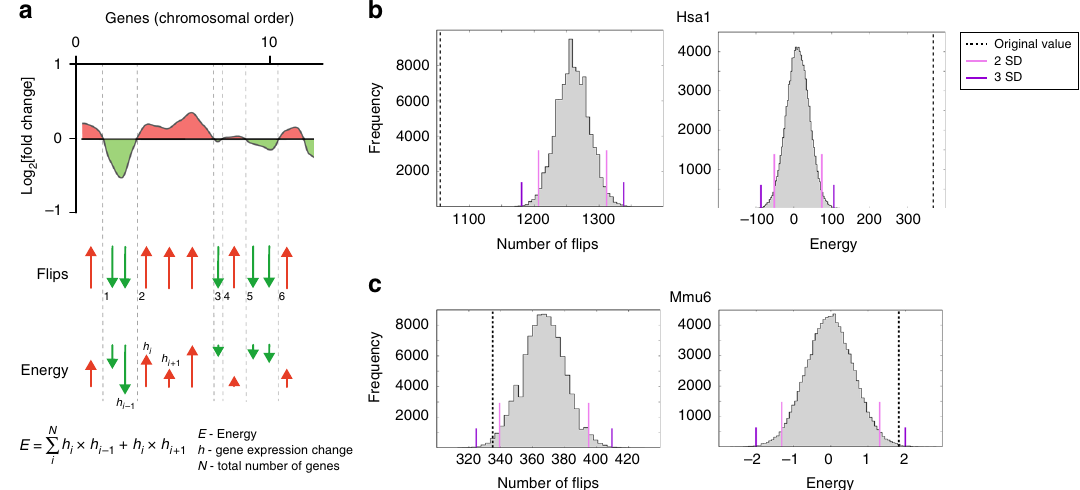
Fig. 3 Statistical tests for gene expression dysregulation domains. a An example plot of fold change of gene expression against chromosomal position showing regions in which expressed genes are upregulated or downregulated (red and green, respectively). Below this are shown the directions of the fold changes (red and green arrows) with a dashed black line indicating a fl ip, i.e. a change in direction of the fold change. In the example shown, there are six fl ips. The energy function ( E ) is calculated by taking into account both the direction and magnitude of the fold change and is de fi ned as the sum over all genes on the chromosome of the products of the fold change ( h ) of a given gene ( i ) with the fold change of the previous gene ( i – 1) and the same product with the next gene ( i + 1). b Distribution of fl ips and energy in 100,000 versions of, for example, Hsa1 each with a different randomised order of genes from the human Down syndrome fi broblast expression data 3 . Pink and purple lines indicate 2 and 3 standard deviations (SD) away from the mean, respectively; dashed line shows the fl ips and energy for the actual non-randomised chromosome. c Distribution of fl ips and energy as described in b , for example